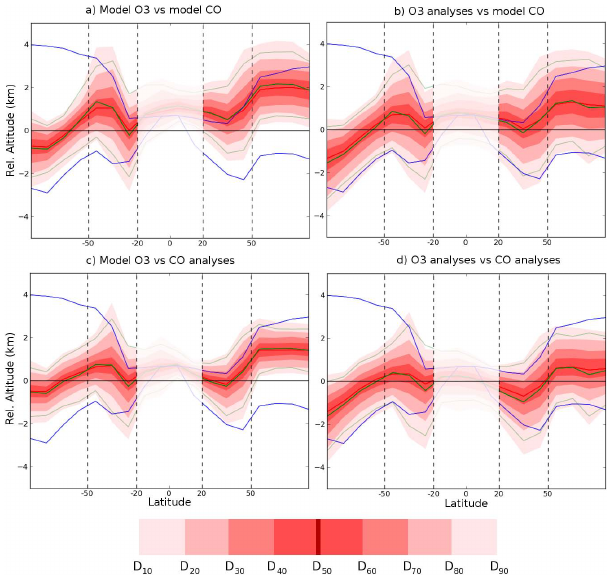
Fig. 7. Latitudinal height variations in altitude coordinates (km) rel- ative to the 360K level of the ExTL distribution for model O 3 vs. model CO (a) , O 3 analyses vs. model CO (b) , model O 3 vs. CO analyses (c) and O 3 analyses vs. CO analyses (d) calculated from the 15 August 2007 12:00UTC tracer fields. Red-filled contours provide the decile altitudes of the distribution. Red and green lines are the median and mean altitudes, respectively. Blue lines show the lowermost stratosphere bounds: the lower line provides the 2PVU contour in absolute value, while the upper line provides the 380K isentropic